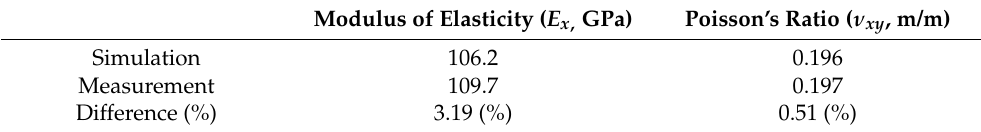
Table 10. Difference between simulation and measurement for Type III.